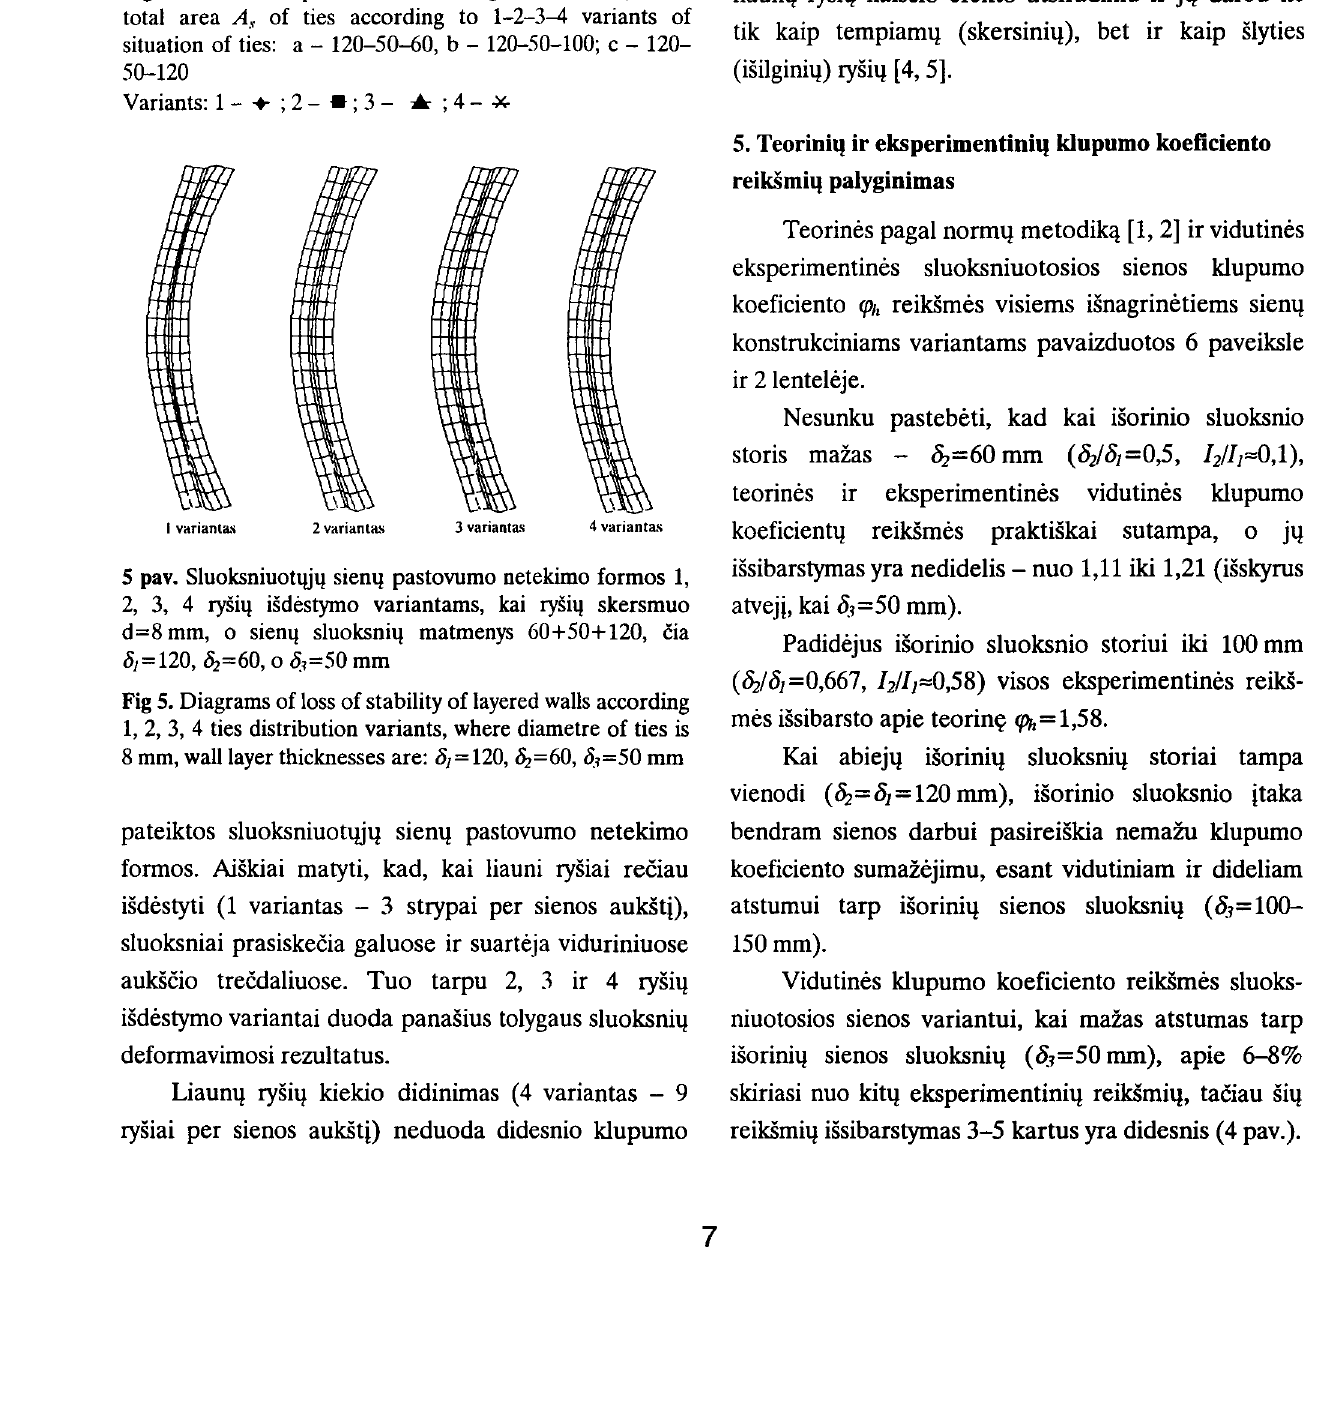
Fig 4. Relationship between buckling coefficient (/Jh and total area A_,. of ties according to 1-2-3-4 variants of